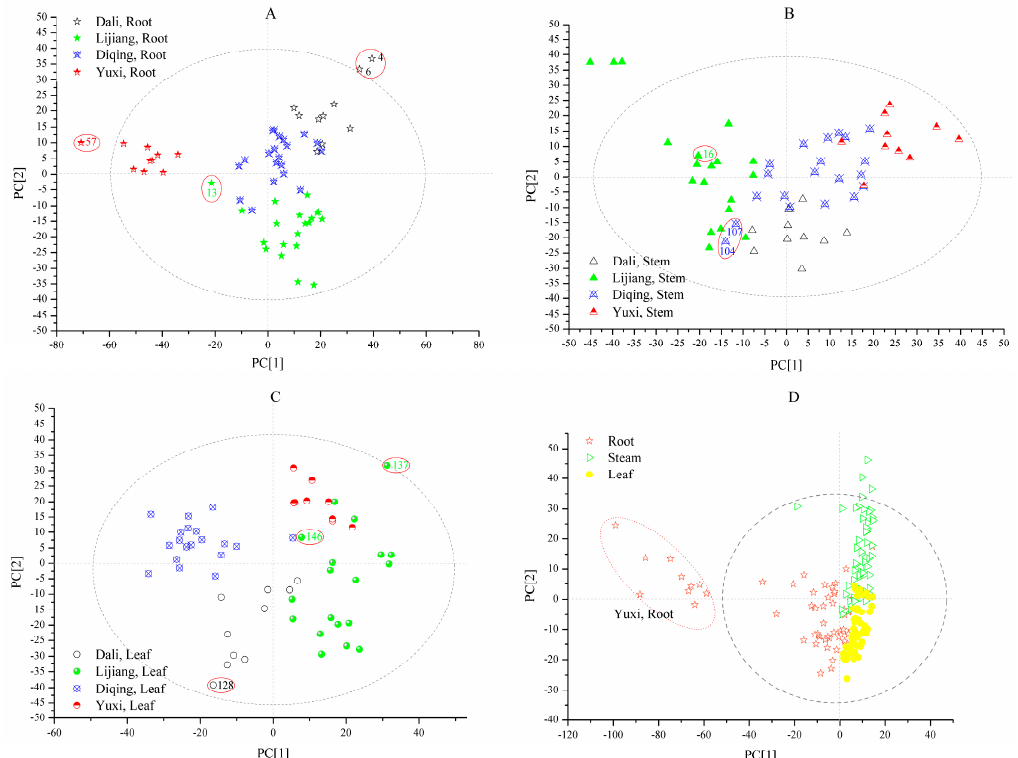
Figure 3. The scatter plot of PLS-DA FT-IR spectra display the information of samples of root ( A ), stem ( B ), leaf ( C ) and three parts (root, stem and leaf) ( D ) in G. rigescens from different geographical origins (Dali, Lijiang, Diqing and Yuxi). The abscissa represents the variation of the first component and the ordinate represents the variation of the second component .